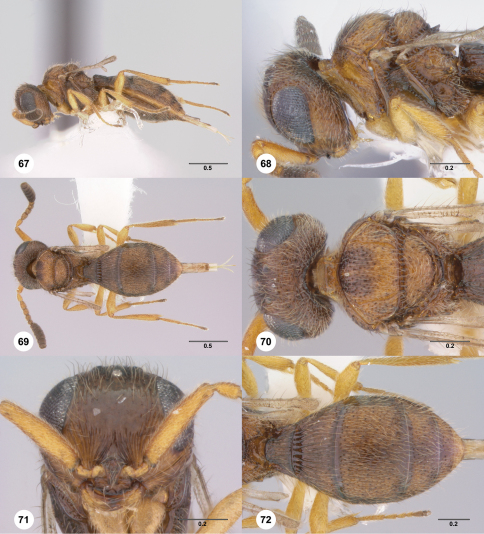
73Paridris reptilis sp. n., female holotype (OSUC 181211) 67 Lateral habitus68 Head and mesosoma, lateral view69 Dorsal habitus70 Head and mesosoma, dorsal view71 Head, anterior view72 Metasoma, dorsal view. Scale bars in millimeters.